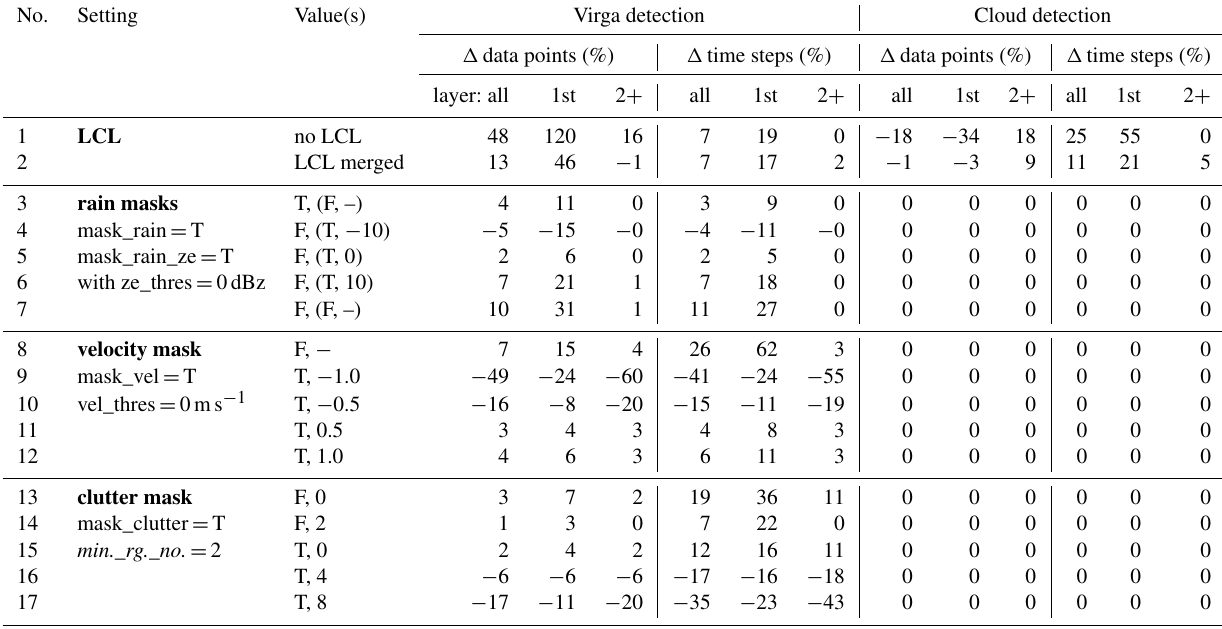
Table B3. As Table B1 but for thresholds and settings for virga detection and virga mask refinement. No. Setting Value(s) Virga detection Cloud detection